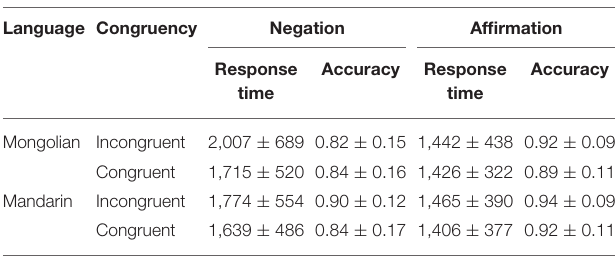
TABLE 2 | Means and standard deviations of response time (ms) and accuracy rate (%) at 250 ISI. Language